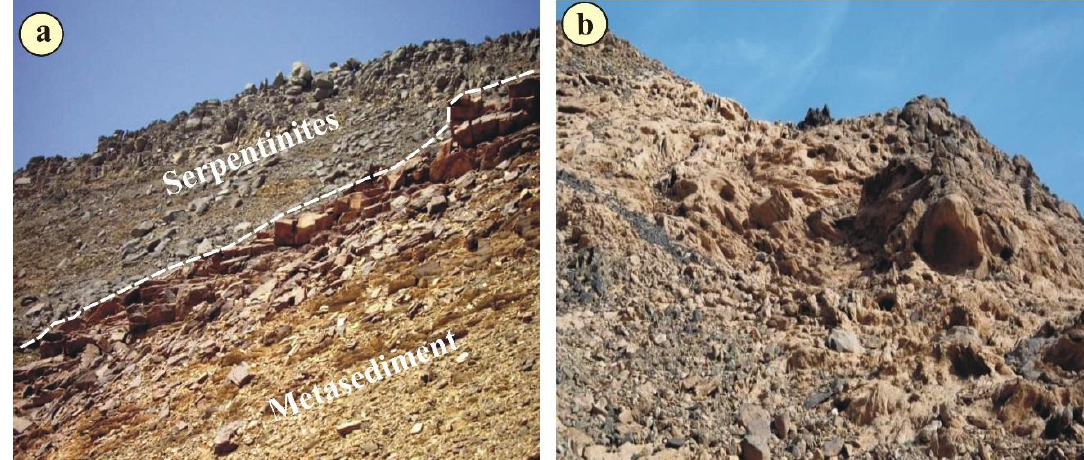
Figure 2. ( a ) Thrust contact between serpentinites and metasediments, and ( b ) pod of talc – carbonate within serpentinites along the shear zone.